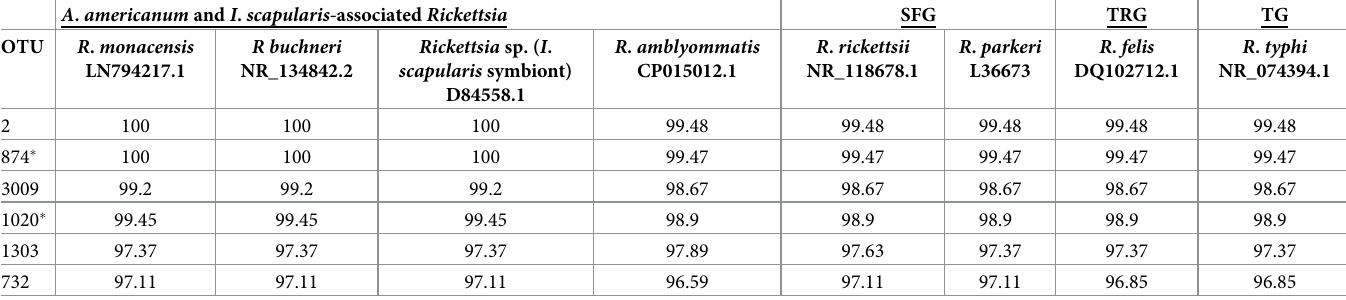
Table 3. Percent identity of Rickettsia OTUs detected in this study to tick-associated Rickettsia and Rickettsia representing the three major Rickettsia clades: Spotted fever group (SFG), transitional group (TG), and typhus group (TRG) [48]. Each OTU included in this table is represented by at least 200 reads. Asterisks denote OTUs that were detected only in I . scapularis ; all other OTUs were detected in both tick